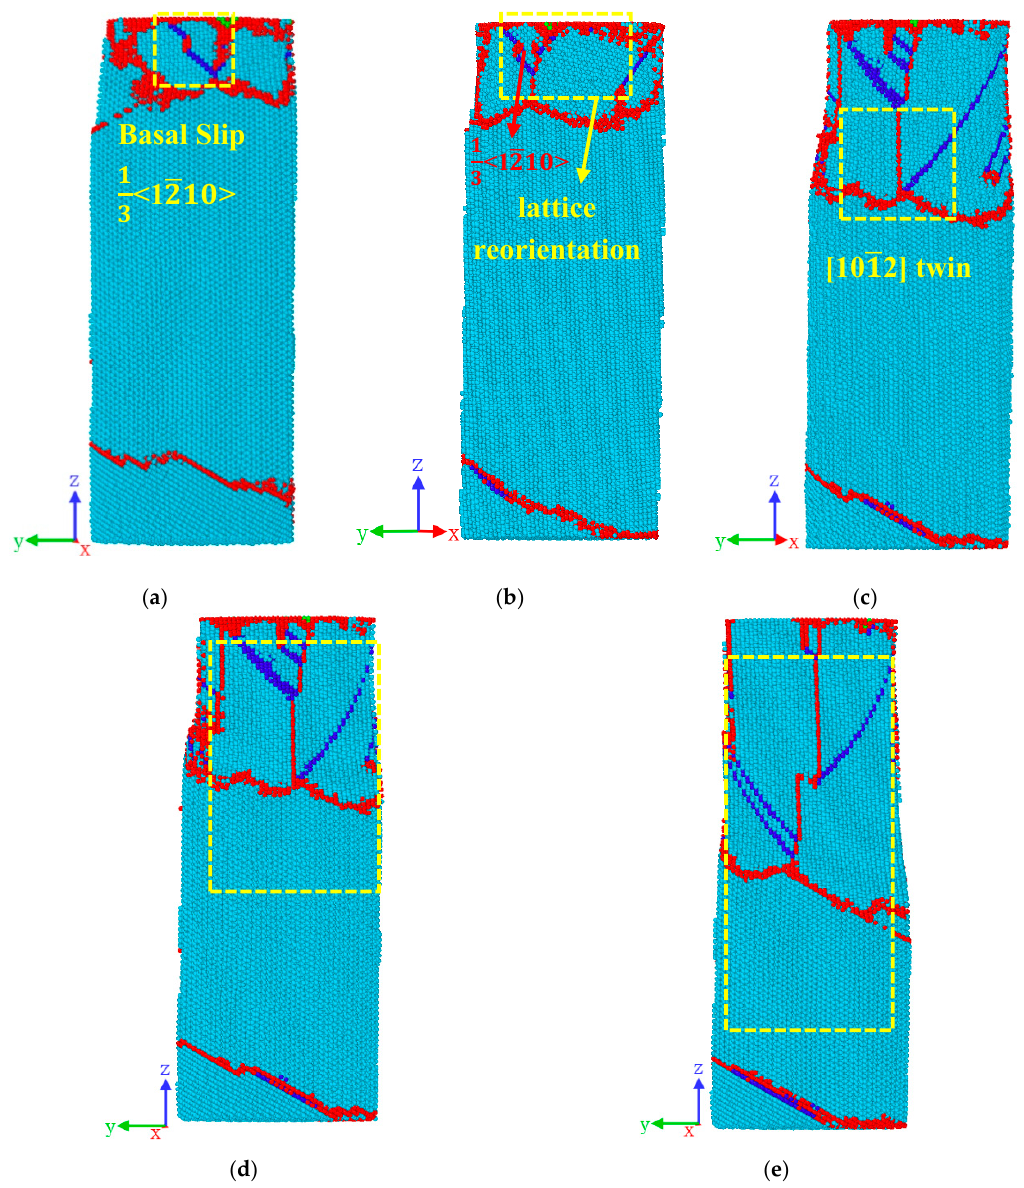
Figure 7. The nucleation and growth process of { 1011 }(cid:104) 1012 (cid:105) twin at the compressive strains of: ( a ) 0.086; ( b ) 0.089; ( c ) 0.104; ( d ) 0.104; ( e ) 0.149. Snapshots in Figure 7a–e are related to the tagged Points (O–S) in Figure 2.